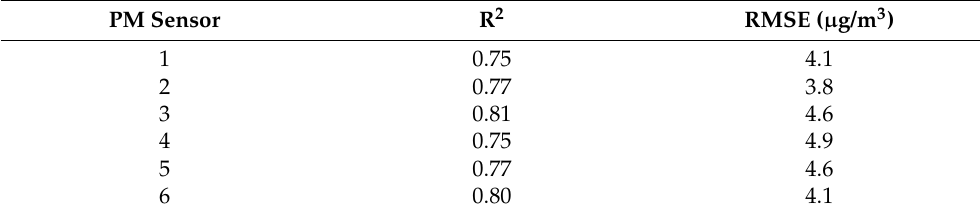
Table 3. Calibration model results for different PM sensor data.